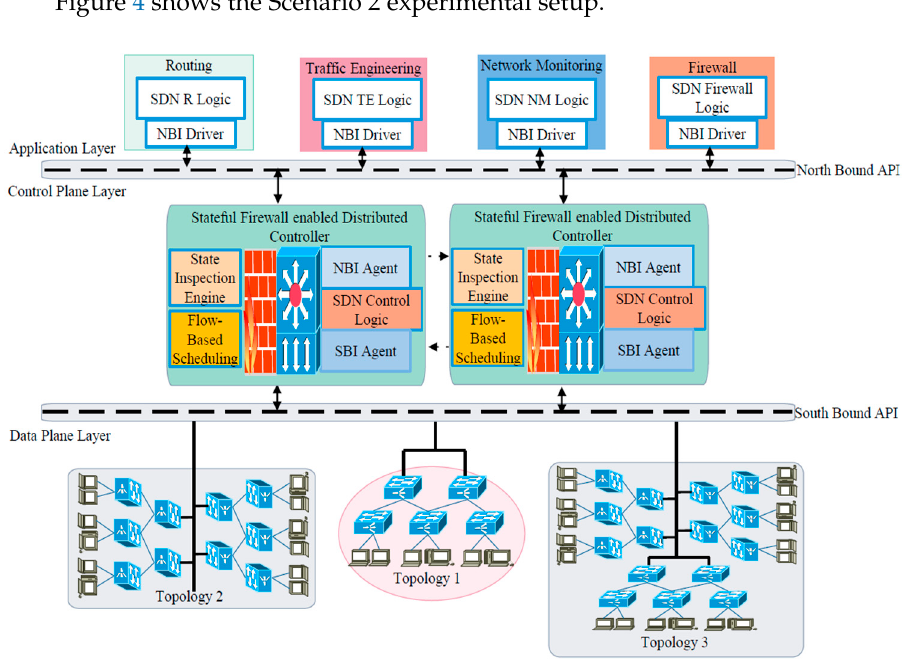
Figure 4. Stateful firewall-enabled two distributed SDN controller.